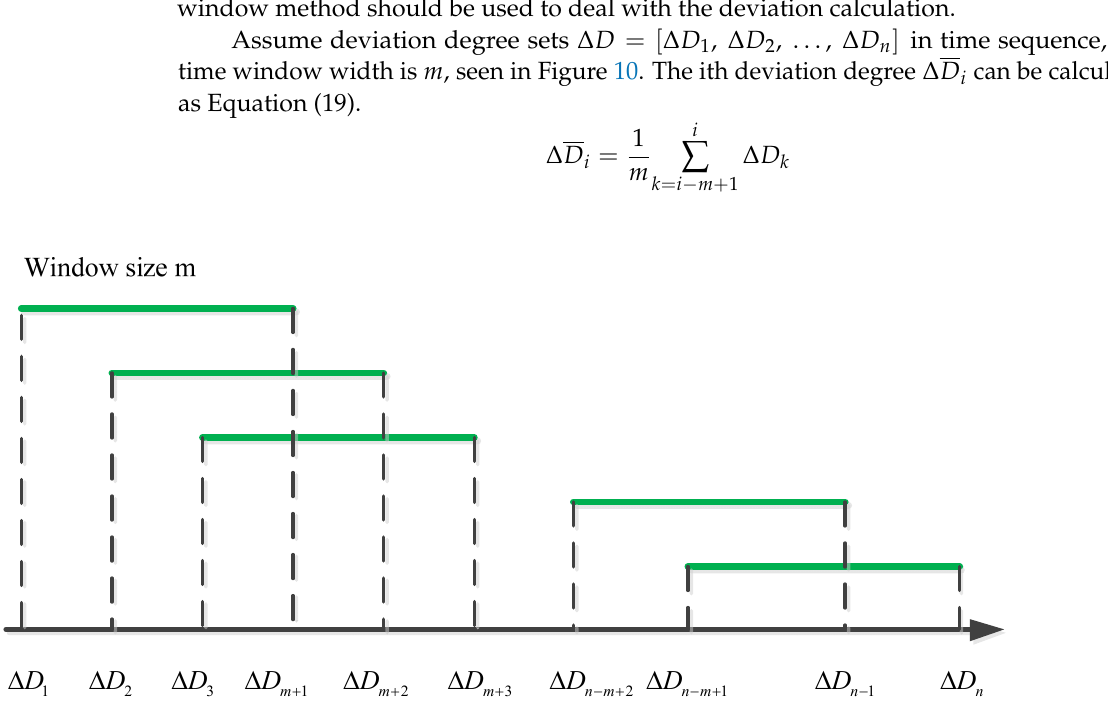
Figure 10. Deviation degree values in sliding time window.